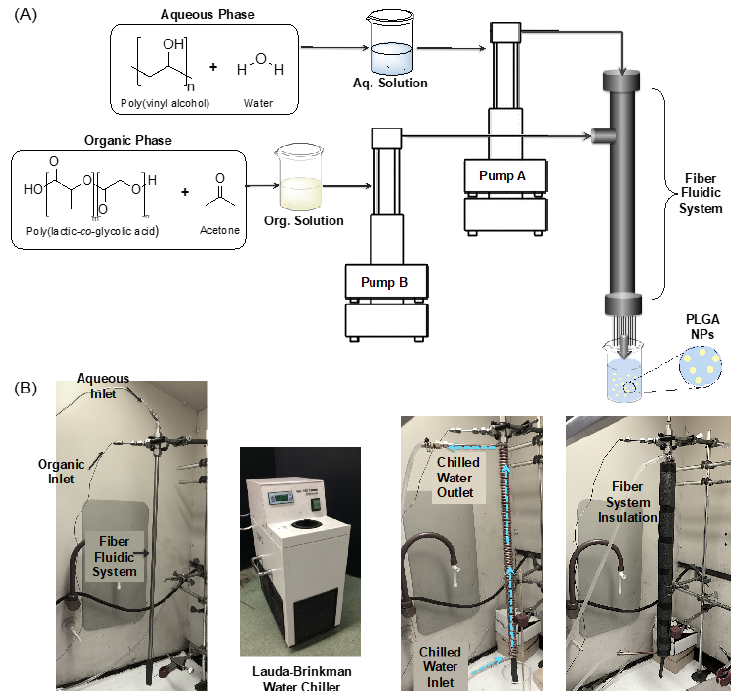
Figure 1. Fiber reactor setup. ( A ) Schematic of experimental fiber fluidic system setup. The fiber fluidic system has two inlets that are fed with syringe pumps. The aqueous phase, including poly (vinyl alcohol) (PVA) as a stabilizer, enters the system first, wetting the fibers. The organic phase, containing the polymer poly(lactic- co -glycolic acid) (PLGA) and active agents, is fed downstream. Nanoparticle (NP) suspensions exit the fiber reactor through the outlet, which is open to atmospheric pressure. ( B ) Left to right: Images of the bare fiber fluidic system, water chiller, fiber fluidic system wrapped with cooling coil, and fiber fluidic system with cooling coil and